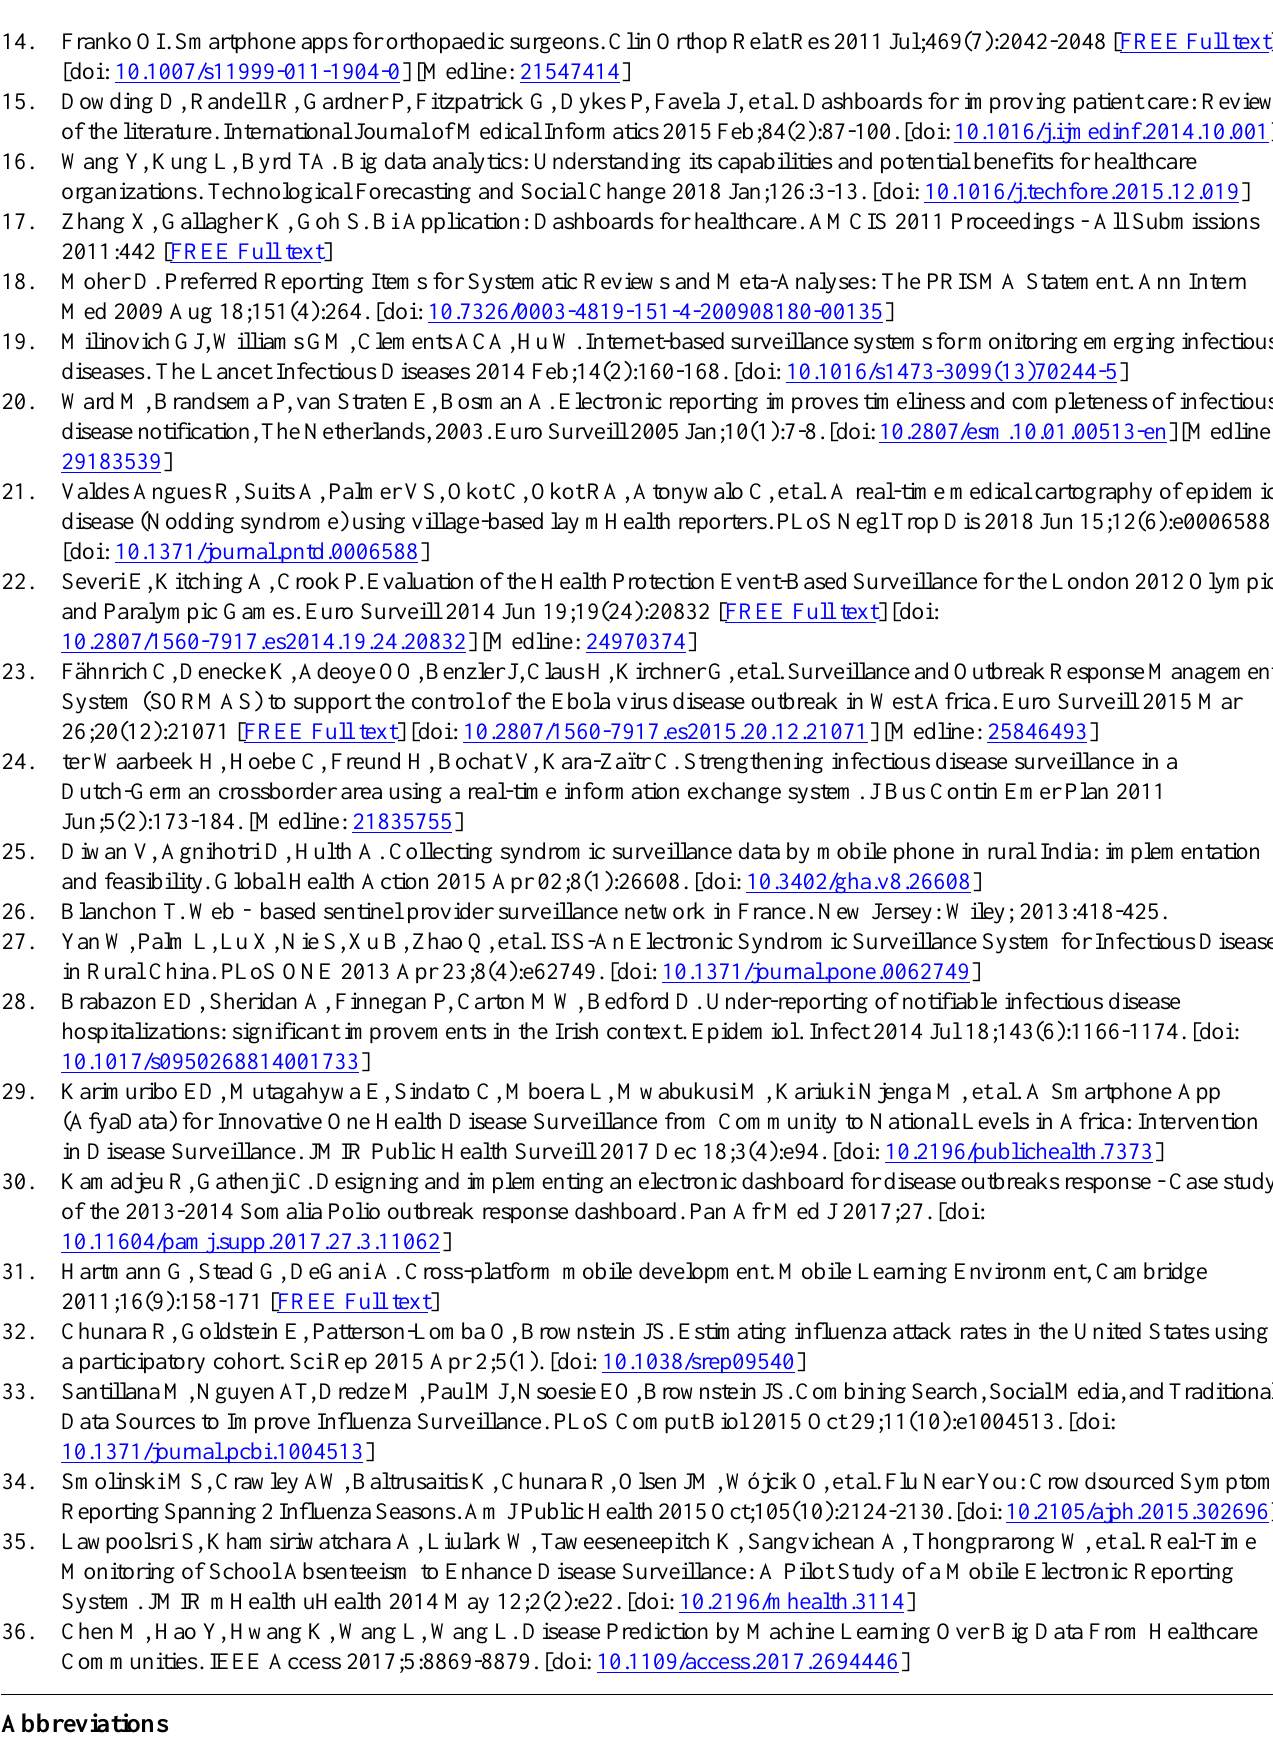
CSS: Cascading Style